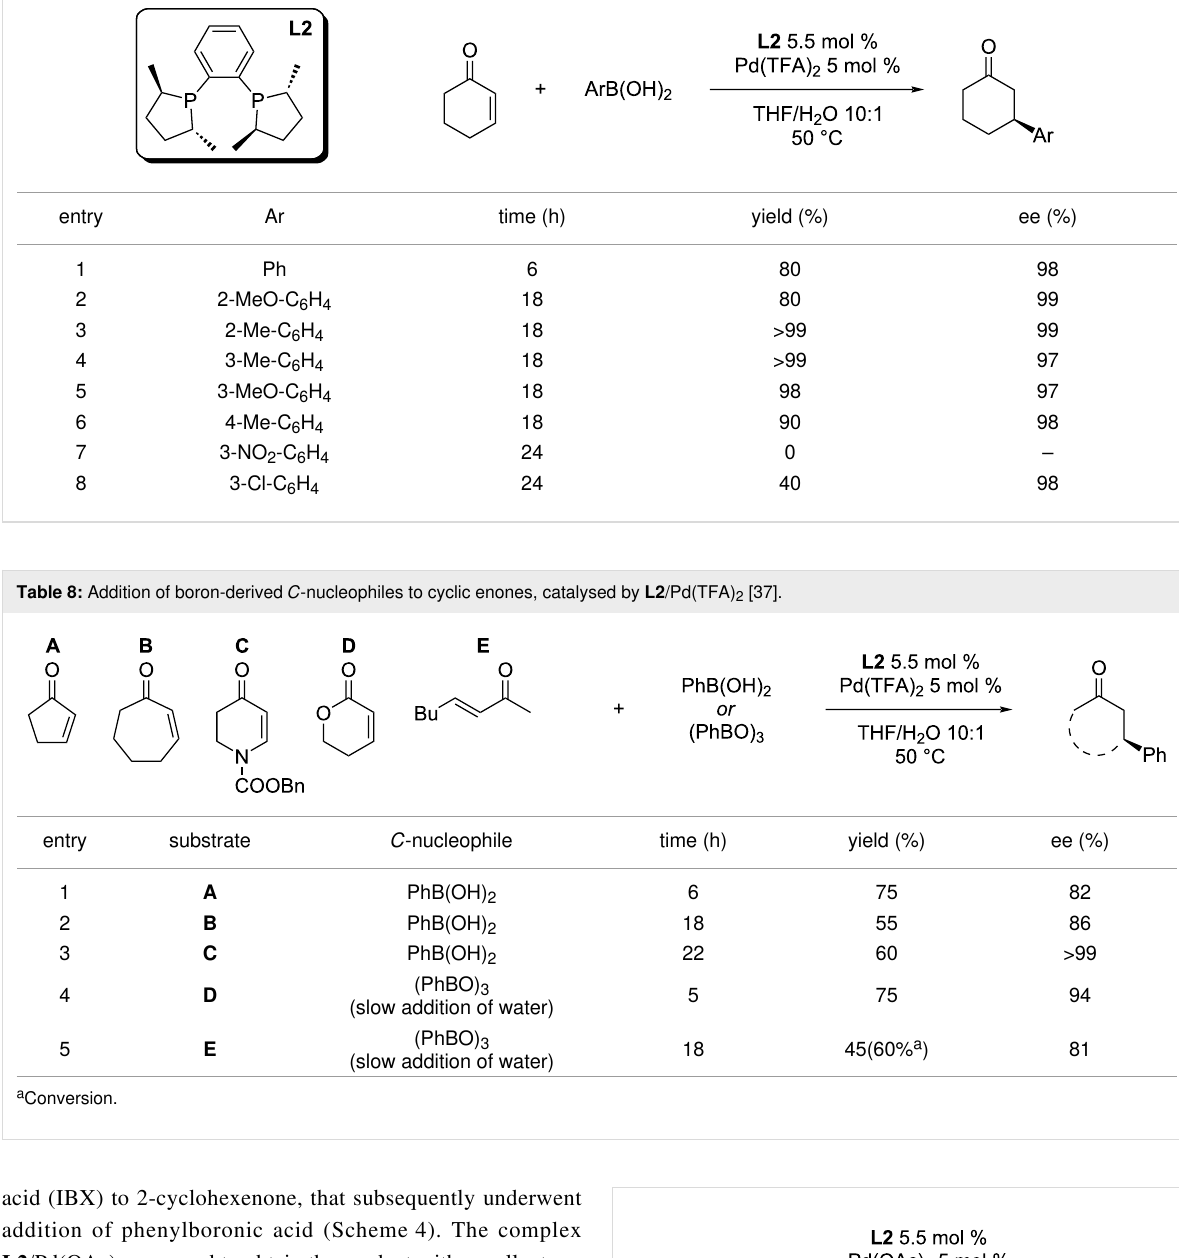
Table 7: First report of the Pd-catalysed enantioselective addition of boronic acids to cyclic enones [37].